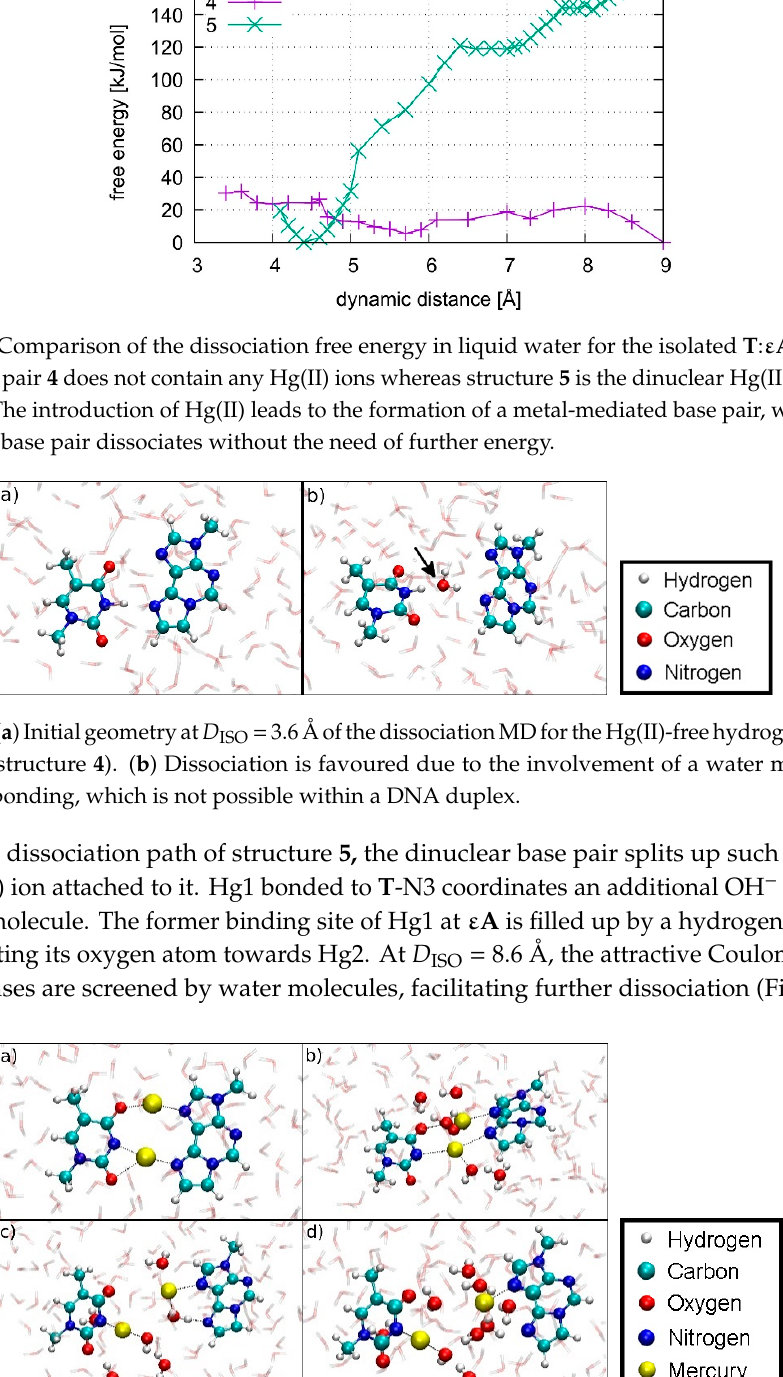
coordinates the T -N3-bonded Hg1. ( d ) D ISO = 8.6 Å, final geometry of the dissociation MD. Hg1 remains attached to T -N3 and carries an additional OH – ligand, Hg2 binds ε A -N7, while the water molecules form a bridge with their oxygen atoms pointing towards to the positively charged Hg(II) Figure 20. Snapshots of the dissociation MD for the metal-mediated base pair (structure 5 ). ( a ) D ISO = and their protons facing the electronegative O and N atoms of the nucleobases. 4.4 Å, initial geometry. ( b ) D ISO = 6.4 Å, formation of an H 3 O + and an OH – close to Hg2. ( c ) D ISO = 7.3 Å, coordination of a water molecule at the former ε A -N6 binding site of Hg2, while the OH –